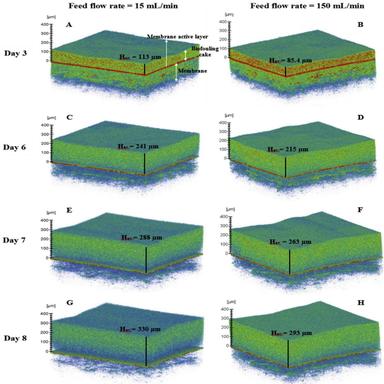
3-D visualization of biomass grown on UF membrane at a feed flow rate of 15 mL/min and 150 mL/min during the compression process exerted at days 3, 6, 7 and 8.